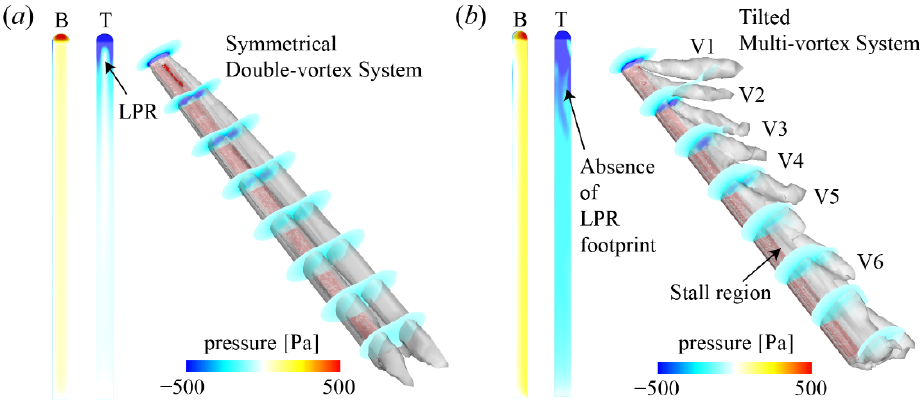
Figure 7. Effects of β on the flow structure and pressure distribution of the ski: ( a ) α = 30°, β = 0°, and γ = 0° and ( b ) α = 30°, β = 40°, and γ = 0°. B: bottom view; T: top view; V: vortex. The ski is labeled by the red region.